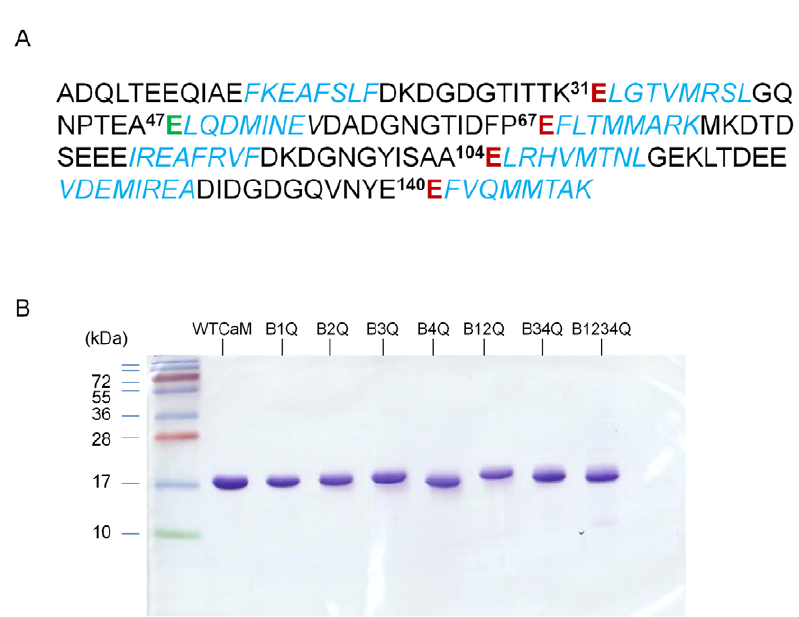
Figure 1. CaM mutant constructs. A: The sequence of human CaM is shown, using single-letter amino acid residue codes. The mutated amino acid residue in each calcium-binding site is marked in red. Helical regions are shown in Italics and blue color. B: The electrophoretic mobility of wild- type and mutant CaM proteins was analyzed by SDS-PAGE. A 5- m g sample of each CaM construct was loaded in a 15% SDS-PAGE which was run with a standard Laemmli SDS-PAGE buffer in the presence of 1 mM EGTA. Molecular masses of protein standards are shown on the left in kilodaltons (kDa).